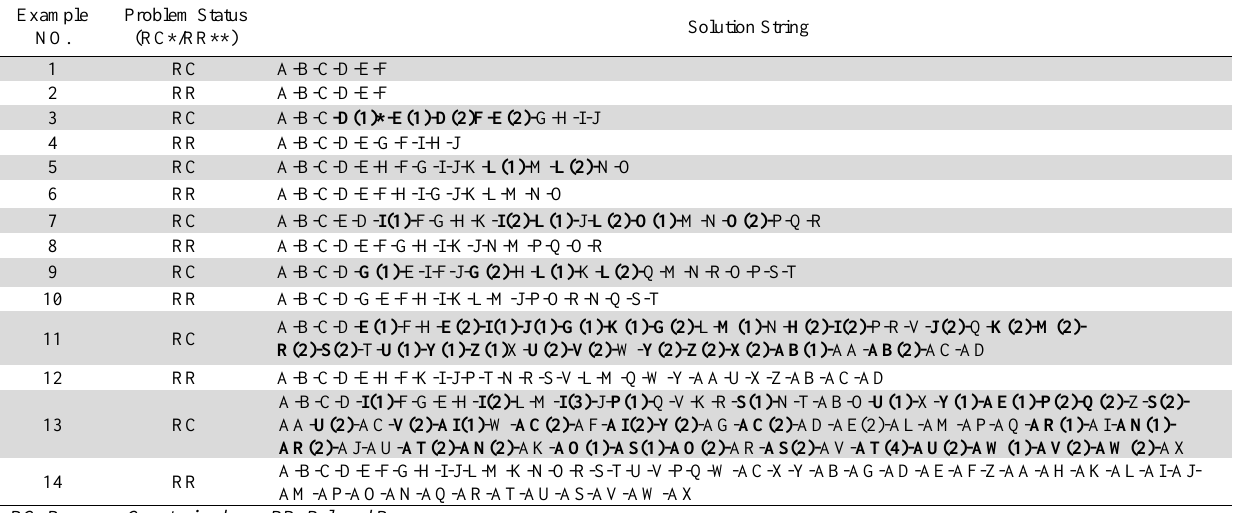
*RC: Recourse Constrained **RR: Relaxed Resource Note activities that are taken apart shown in